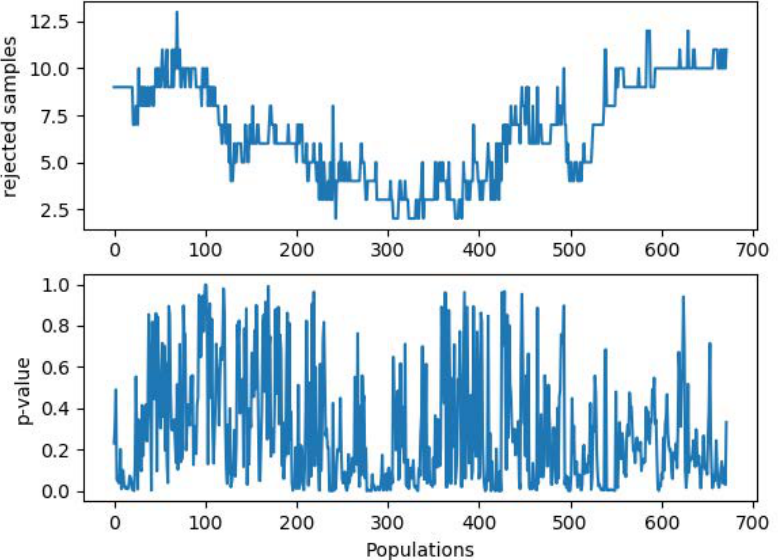
Figure 5. Generalized ESD application: rejected samples ( above ) and relevant p -value of the new population without outliers ( below